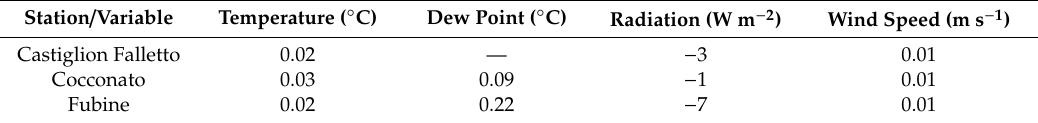
Table A1. Root mean square error for daily mean values of UTOPIA inputs interpolated in the three vineyards, compared with available